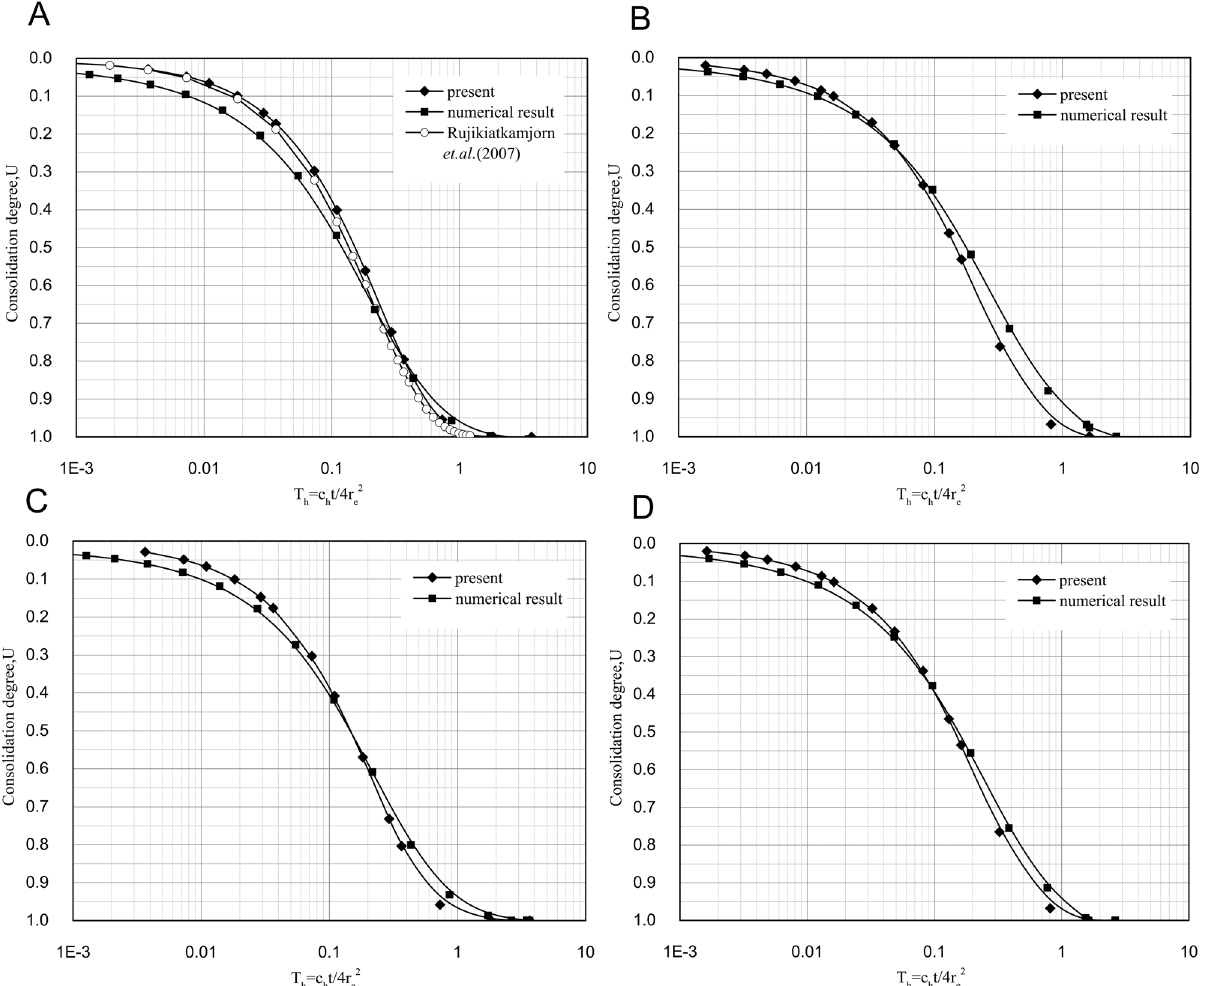
Fig 5. Comparison of this study's solution and the numerical solution for different values of δ and n . (A) δ = 0.45, n = 10. (B) δ = 0.45, n = 15. (C) δ = 0.55, n = 10. (D) δ = 0.55, n =